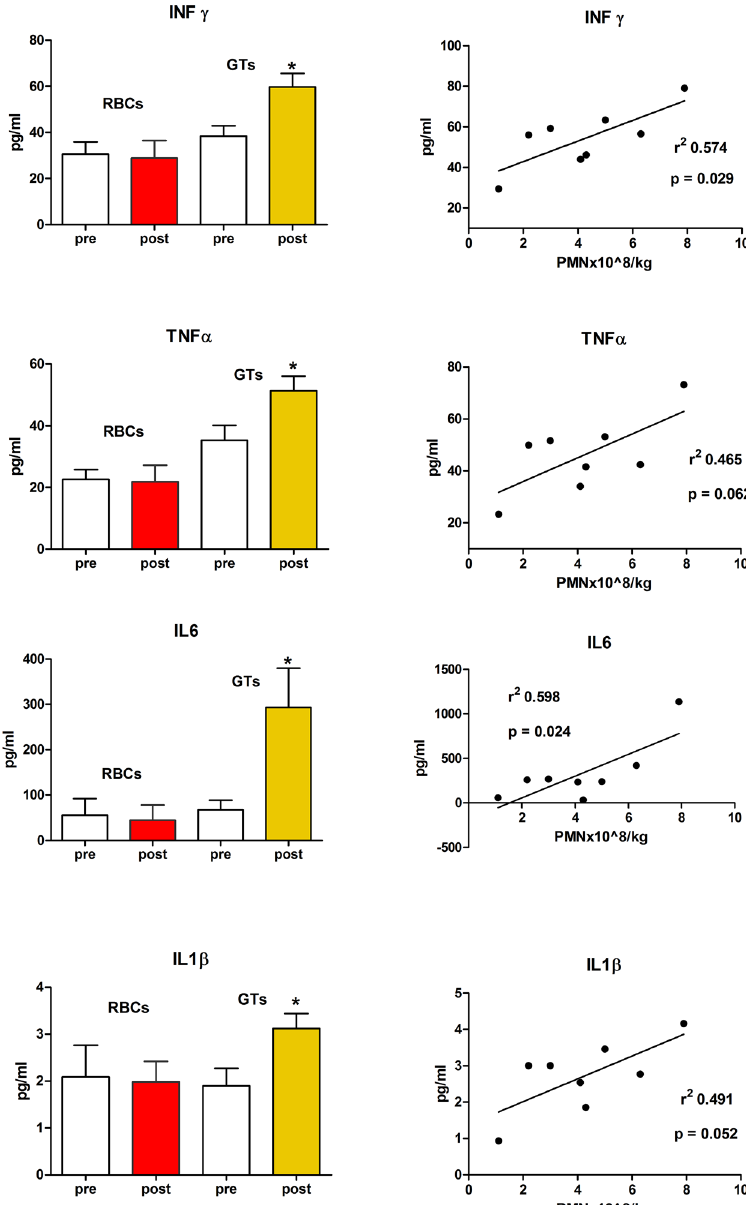
Fig 3. Cytokine plasma concentrations before and after transfusions. IL1 β ,IL6, TNF- α and INF- γ levels were measured in 4 patients receiving 8 GTs and in 6 patients receiving RBCs transfusions, as control. In all patients, samples were collected immediately before and 6 – 8 hours after transfusions. Results are expressed as mean values ± SEM. The cytokine concentration observed in samples collected post-GTs were proportional to the PMN dose delivered. * p <